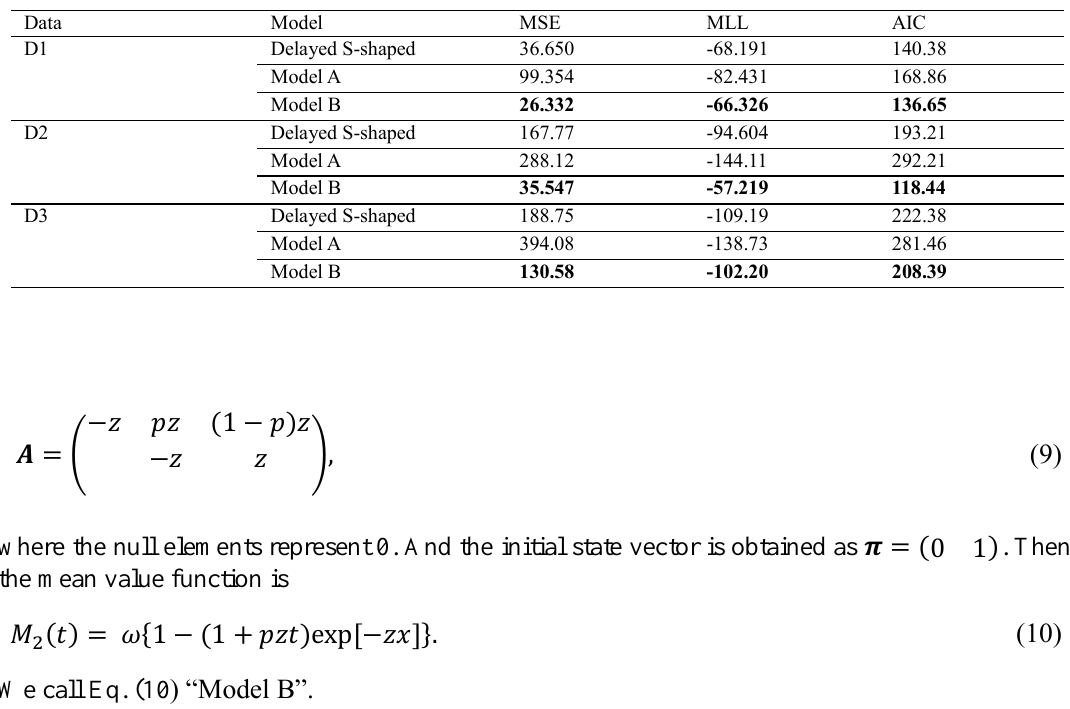
Table 1. Results of goodness-of-fit